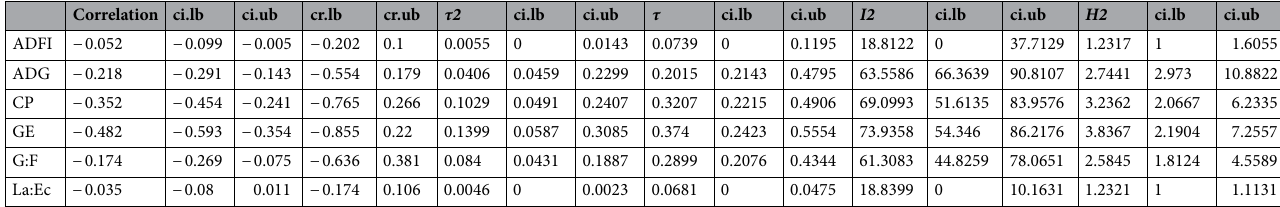
Table 5. Summary of correlation for Predicted Fisher’s r-to-z scores transformed to correlation